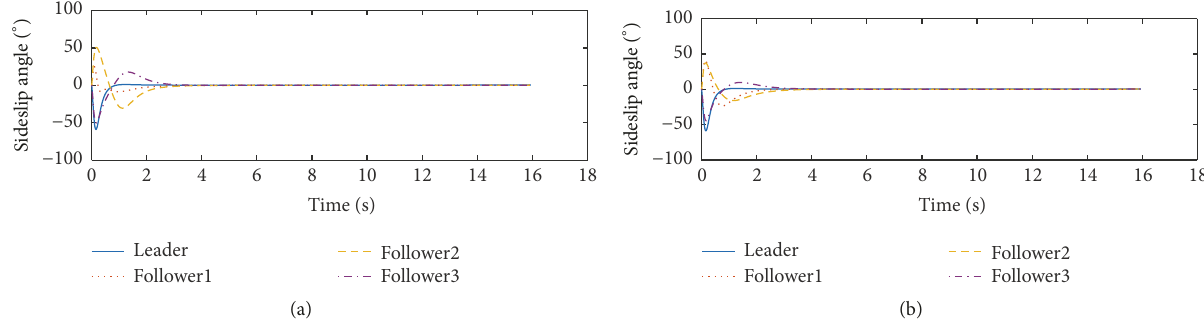
Figure 9: Sideslip angle curve in the global and local communication topologies: (a) sideslip angle curve in the global communication topology; (b) sideslip angle curve in the local communication topology.